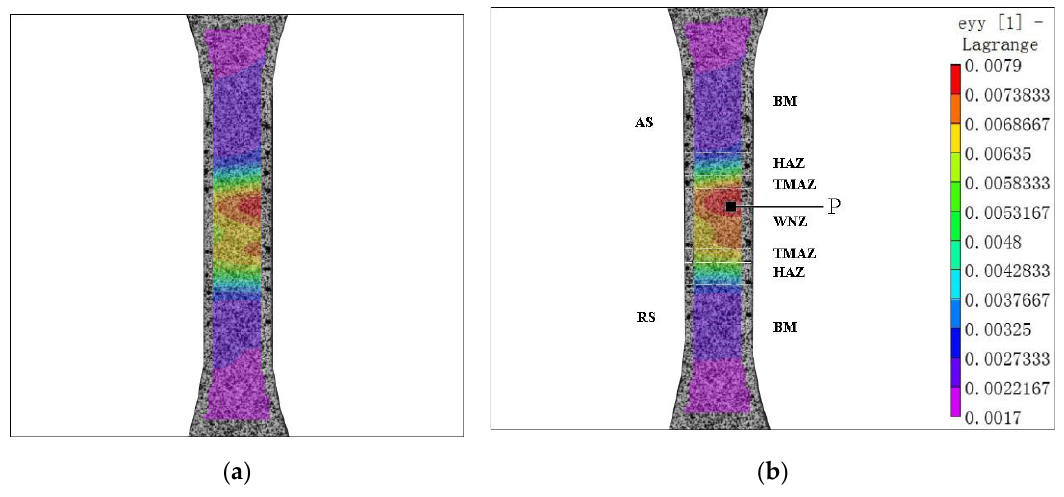
Figure 10. Strain distributions of specimen under a stress ratio of 0.1 at ( a ) 1500 cycles, 42% of total life and ( b ) 3500 cycles, 98% of total life.